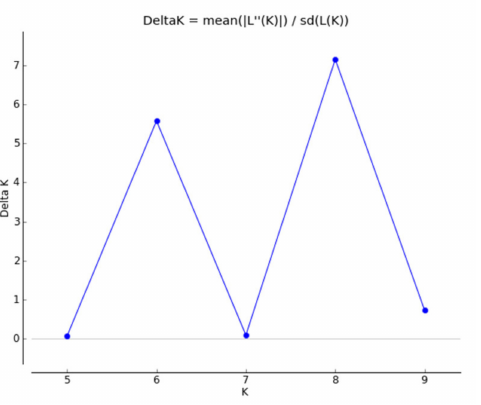
Figure 1. Delta K values for STRUCTURE analysis of dog breeds obtained by the program Struc- ture Harvester.